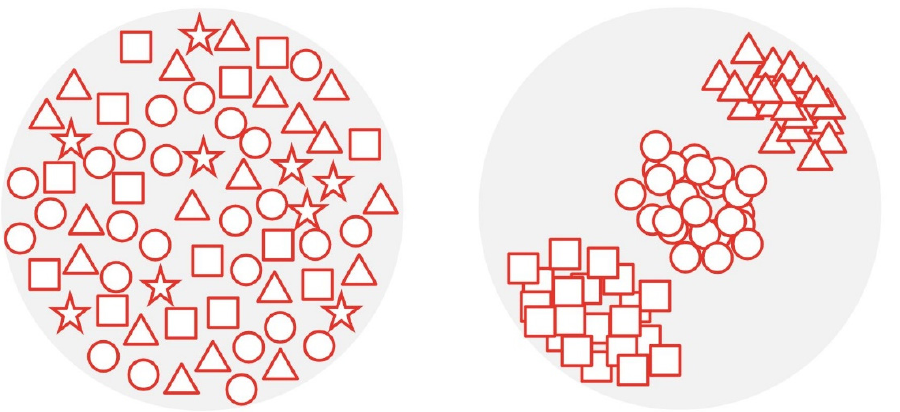
Figure 4. Illustration describing the mechanism of clusterization: In the left image, no specific order can be seen. For clusterization, different shapes are recognized and organized in a group (cluster) as seen in the right image. Shapes that do not belong in any group (e.g., stars) are sorted out. This can help ML models to recognize patterns that would otherwise be difficult to recognize.